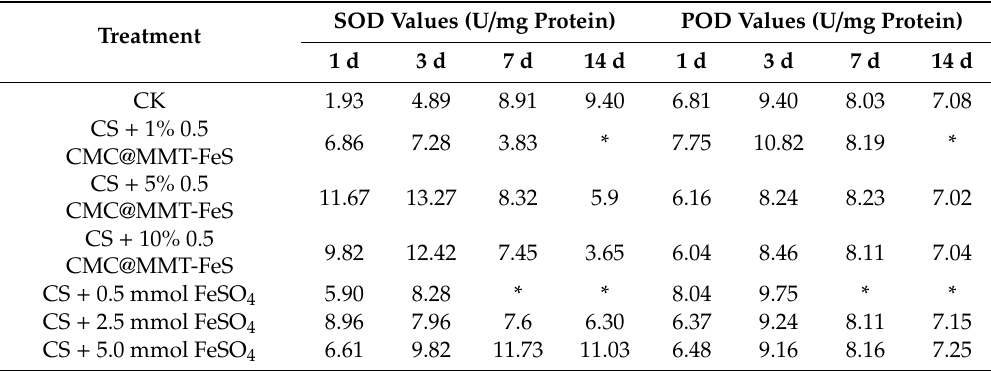
Table 2. Enzyme activity of Eisenia foetida in soil samples on di ff erent days.